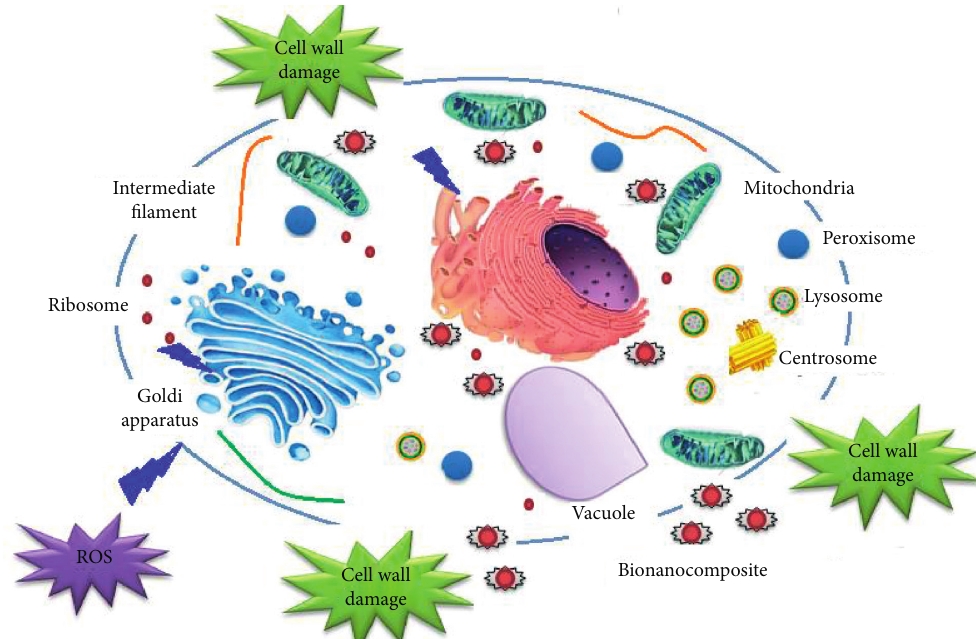
Scheme 2: Schematic representation of the mechanism of antibacterial and cytotoxicity effects of the polymeric P. cylindraceus oil-TiO PEG